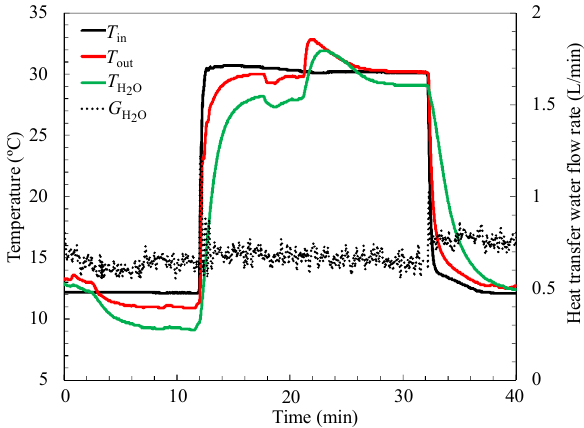
Figure 7. Temperature of the water inside condenser/evaporator; the inlet and outlet temperatures of the heat exchanger on the condenser/evaporator side changes with time.